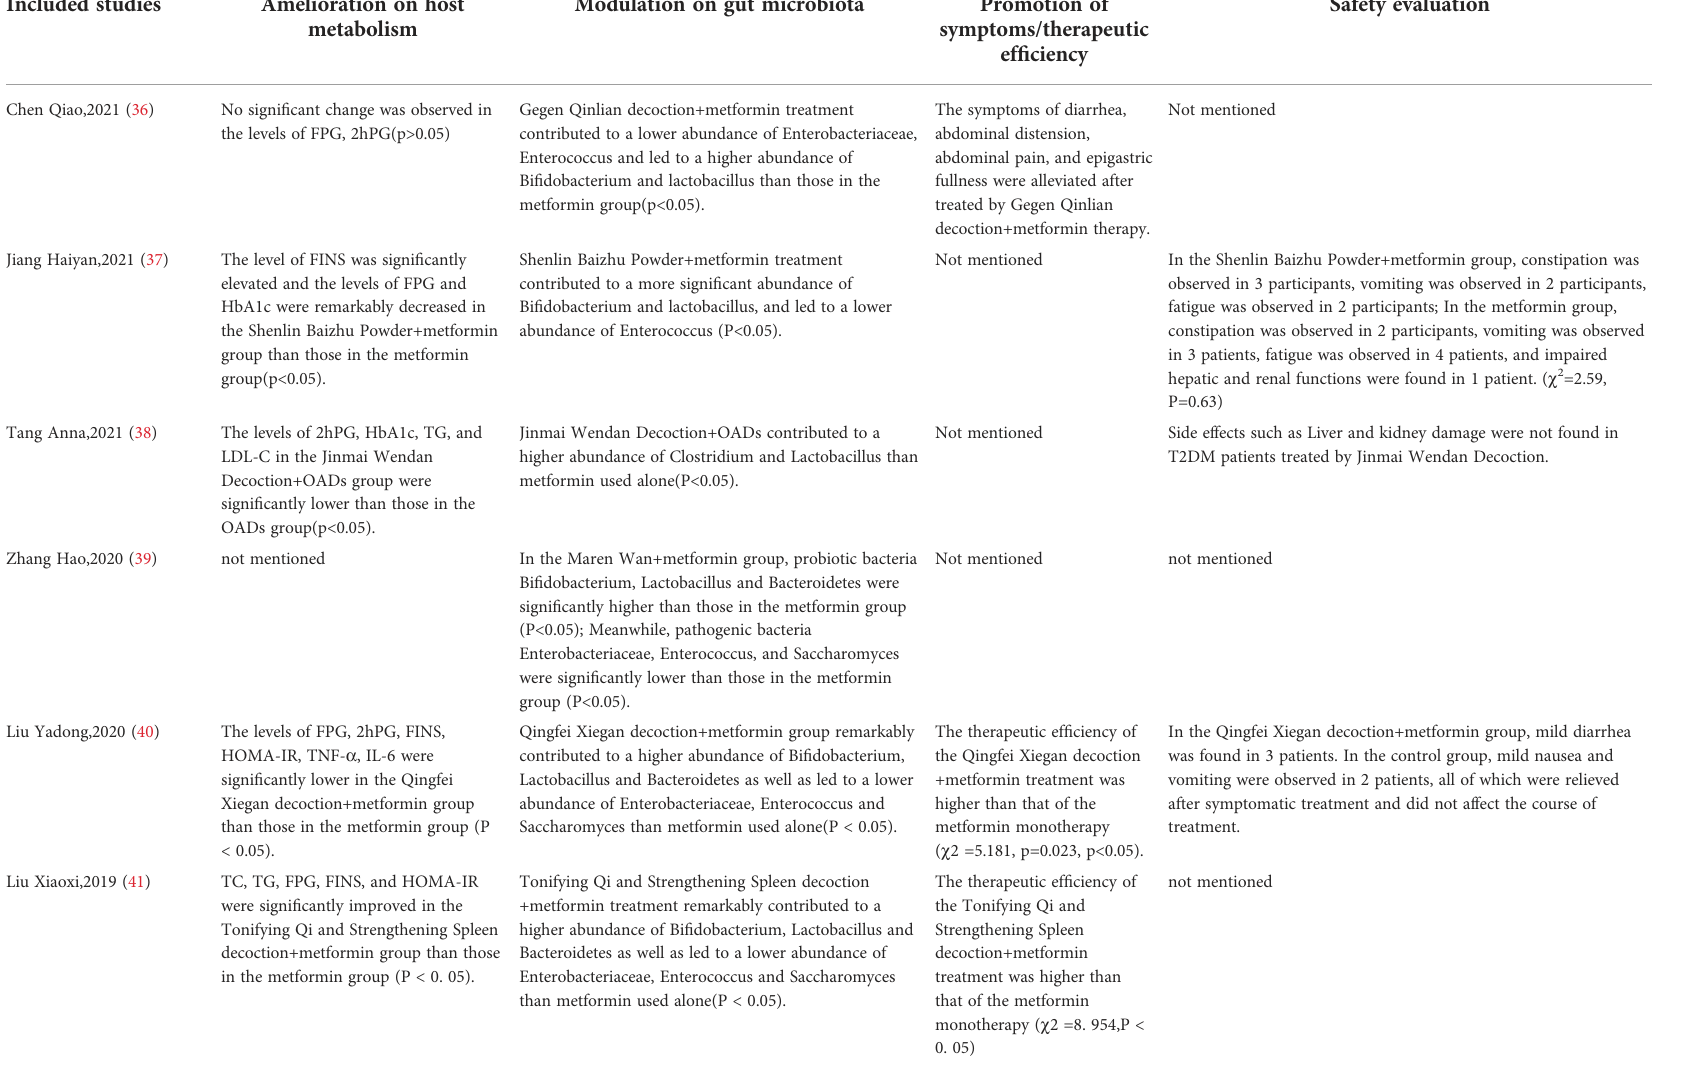
TABLE 4 Summary of the bene fi cial effects of CHFs combined with